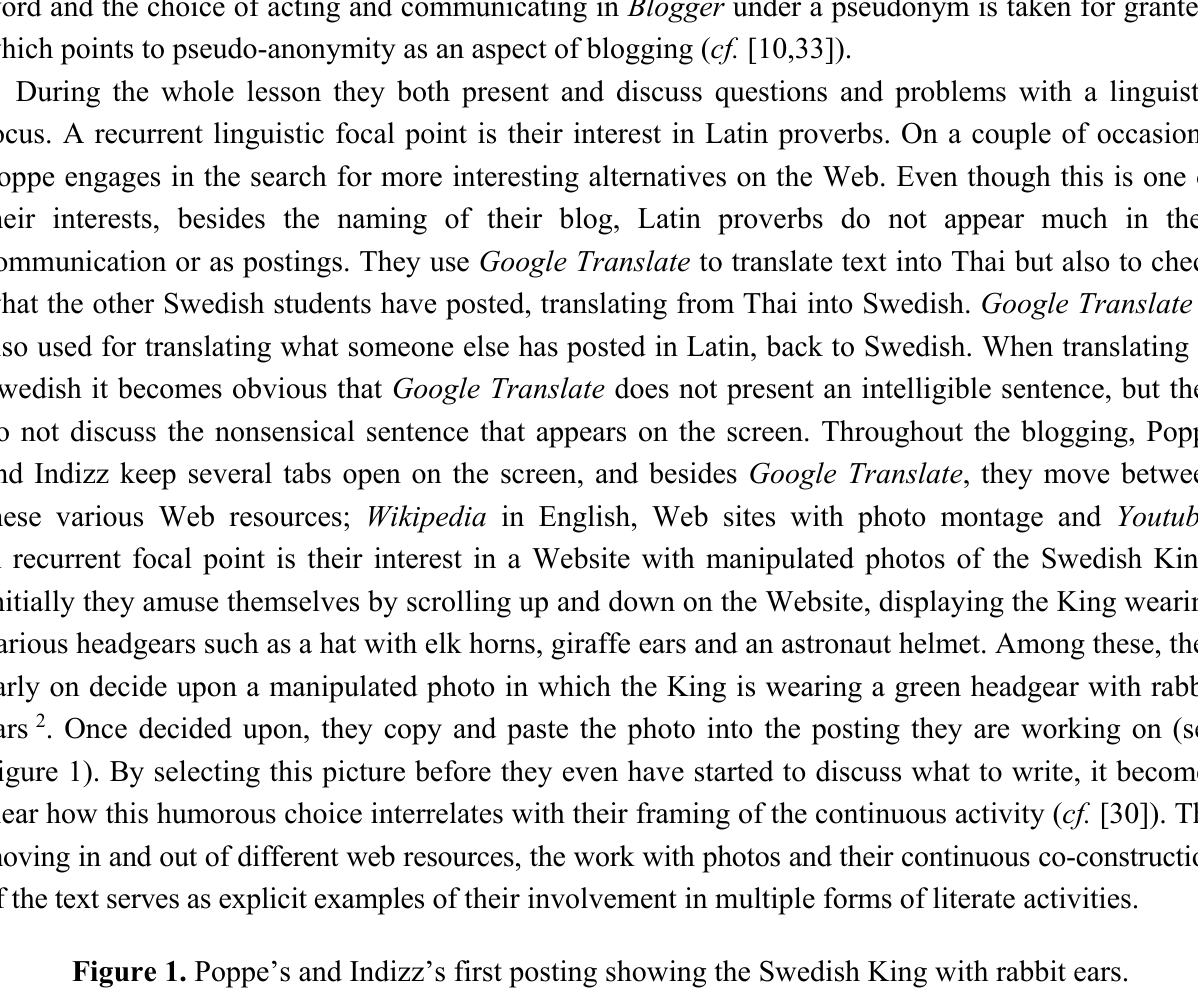
Figure 1. Poppe’s and Indizz’s first posting showing the Swedish King with rabbit